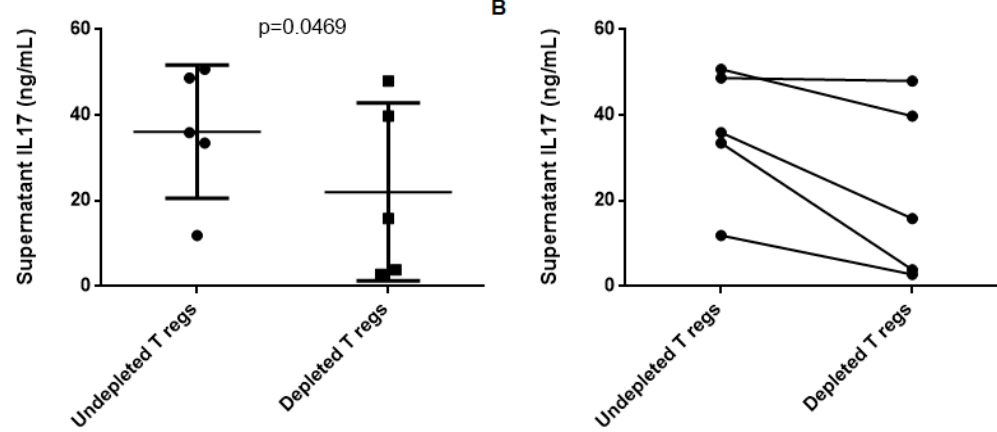
Figure 4. Change in IL-17 production by PBMCs in response to MPO after T-regs depletion in 5